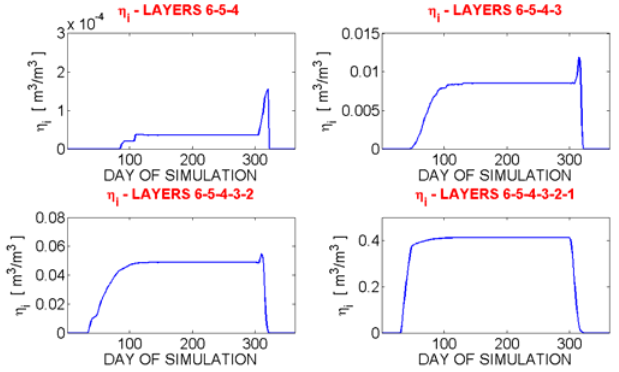
(volumetric ice content) trends relative to the sensitivity test summarized in Figure 12. η i Figure 9, for the fourth layer (top left), the third layer (top right), second layer (bottom left) and first layer (bottom